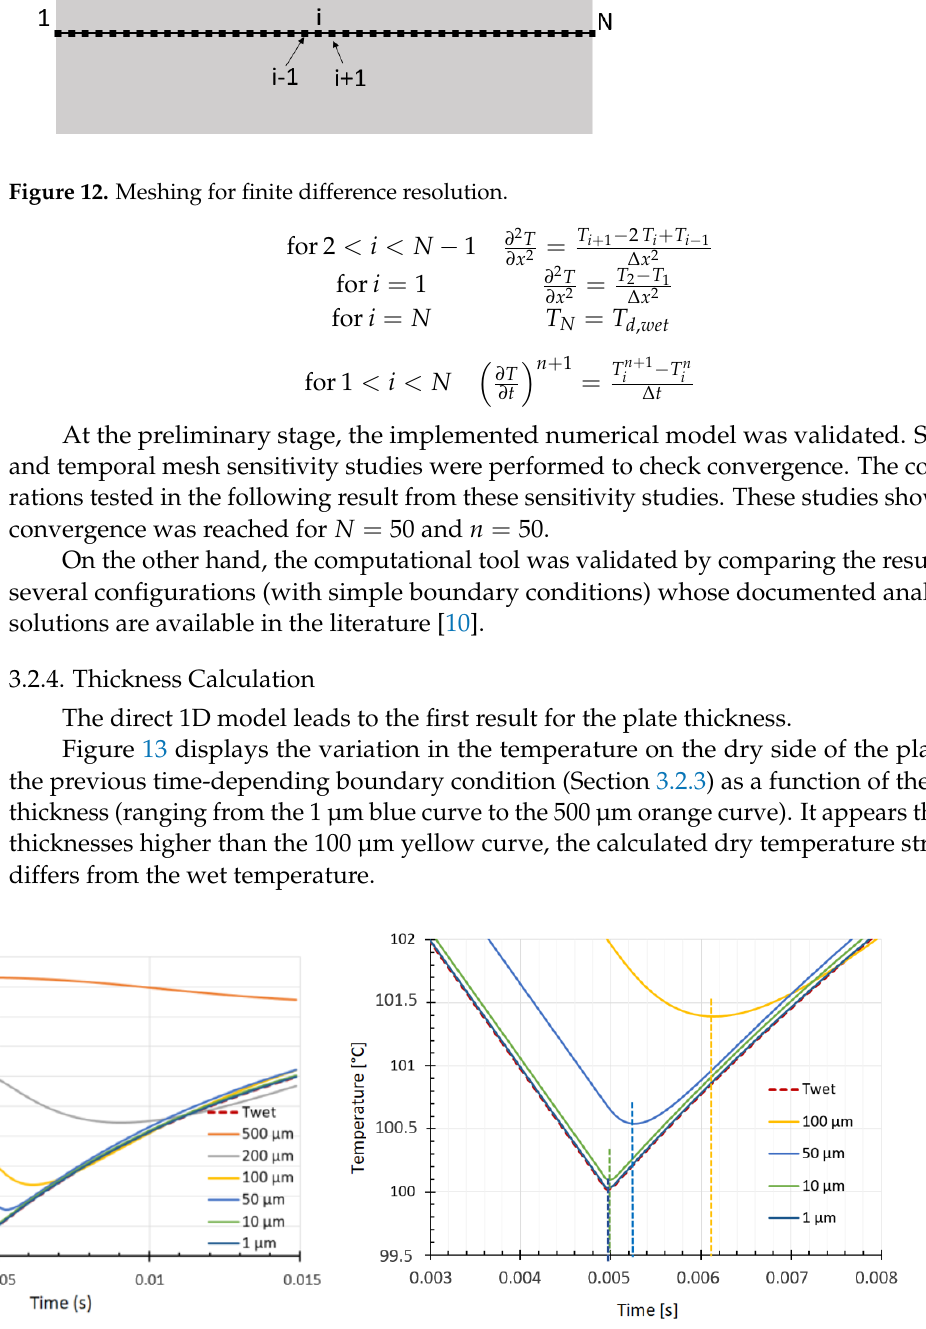
Figure 13. Direct problem–solution: temperature on the external face (dry temperature) as a function of the thickness of the plate. This problem–solution was solved with the following values: N = 1000, n = 50, t g = 0.005s, t w = 0.01s, ∆ t = 0.00031s, P = 1bar, I = 400A, ∆ T = 5 ◦ C, C P = 502J/K · kg, λ = 15W/m · K, ρ = 7960kg/m 3